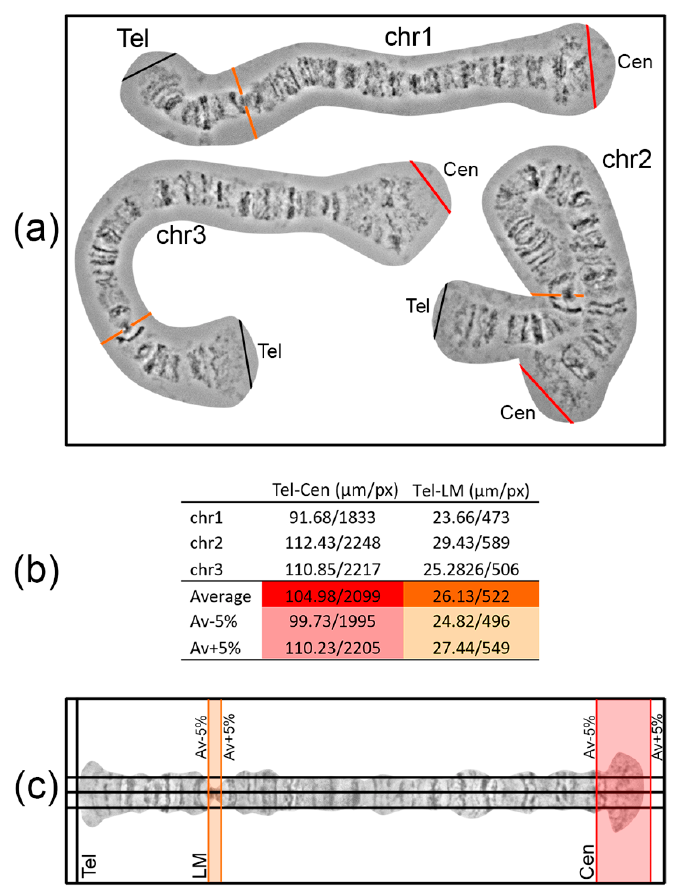
Figure 4. A workflow of the work area layout of the 3L arm of An. sacharovi nurse cells polytene chromosomes. ( a ) Templates of 3L arms, named chr1, chr2, chr3, Tel—telomere (black line), Cen—centromere (red line), with the “bird eye” landmark arrowed by orange line; ( b ) table of the distances between telomere and centromere ends (Tel-Cen), and between telomere end and the “bird eye” landmark (Tel-LM) of 3 arms examples and their average value, with 5% error margins, in microns and pixels; ( c ) work area layout: telomere end (Tel) marked by vertical black guideline, centromere end (Cen) and “bird eye” landmark (LM) positions marked as colored areas limited by the pairs of vertical lines, where the centromere end and the landmark must appear.